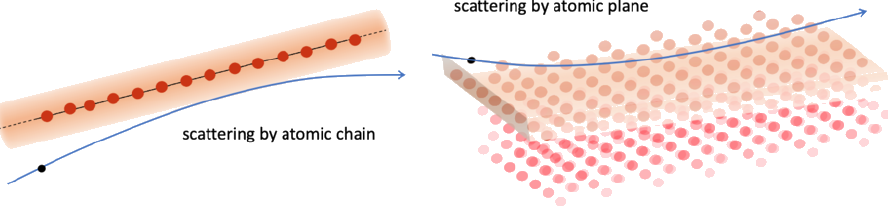
Figure 1. Scattering of a charged particle by a chain or a plane of crystal atoms. At grazing incidence, the interaction can be described by the averaged over the chain or plane atomic potential, i.e., the continuous axial or planar